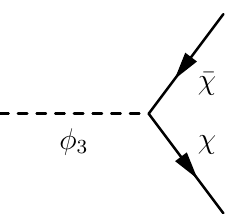
Figure 1. φ 3 → ¯ χχ decay process at tree level.